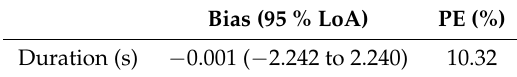
Table 2. Bland–Altman bias (limits of agreement), and percentage error (PE) (computed as 100 × (2 SD of bias)/(( Mean Algorithm + Mean Expert ) /2 ) for the two measurement types. Bias (95 % LoA)